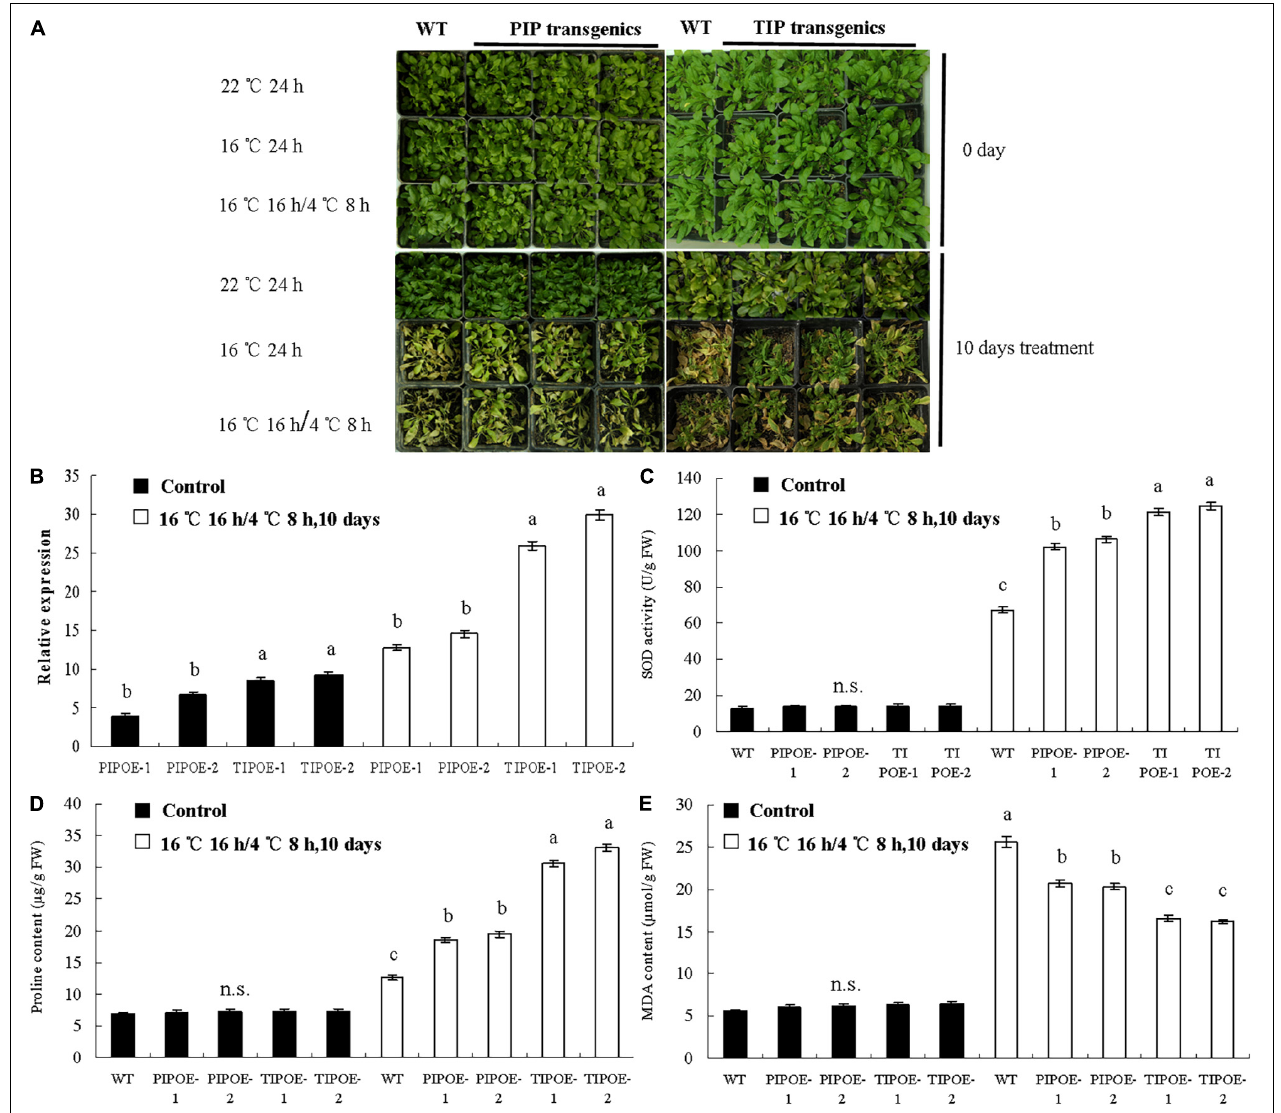
FIGURE 9 | Cold tolerance analysis of wild-type and PaPIP1-3- or PaTIP1-1 -OE plants. (A) Image of the wild-type and transgenic plants in growth chambers at 22, 16, and 16 ◦ C for 16 h/4 ◦ C 8 h. Two independent PaPIP1-3 transgenic lines (PIPOE-1and PIPOE-2) and two independent PaTIP1-1 transgenic lines (TIPOE-1and TIPOE-2), were identified by qRT-PCR. (B) . After 10 days of treatment, the SOD activity (C) , proline content (D) , and MDA content (E) of PaPIP1-3 or PaTIP1-1 transgenic Arabidopsis and wild-type Arabidopsis were determined. PIPOE- 1-, PIPOE- 2-, and PaPIP1-3 -OE transgenic lines; TIPOE- 1-, TIPOE- 2-, and PaTIP1-1 -OE transgenic lines. Actin was used as a control gene. The error bars represent the SEs of three replicates. n.s. means not significant. The different letters represent significant differences at P < 0.05 (one-way